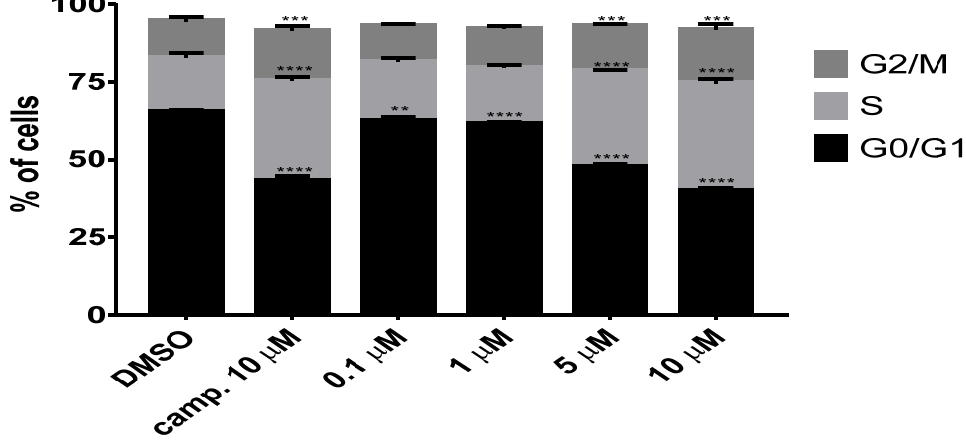
Figure 5. Cell cycle modulation of selenourea 6c at different concentrations after 48 h of treatment compared with the vehicle (DMSO) and 10 µ M of camptothecin (camp.) as positive control. Results are expressed as a mean ± SD of duplicates of three independent experiments, ** p ≤ 0.01, *** p ≤ 0.001 and **** p ≤ 0.0001 compared to the vehicle